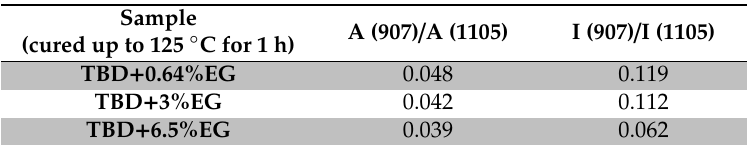
Table 3. DC values of EG-based Table 2. Ratios between the areas and the intensities of the peaks at 907 cm -1 and 1105 cm -1 for samples containing different percentages of EG nanoparticles.